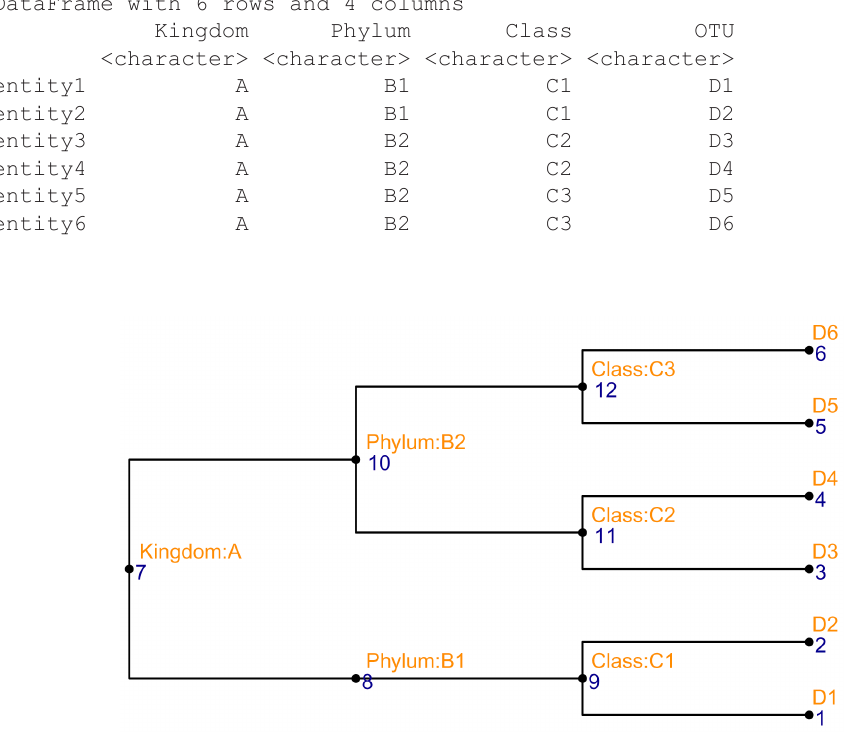
Figure 4. The structure of the taxonomic tree that is generated from the taxonomic